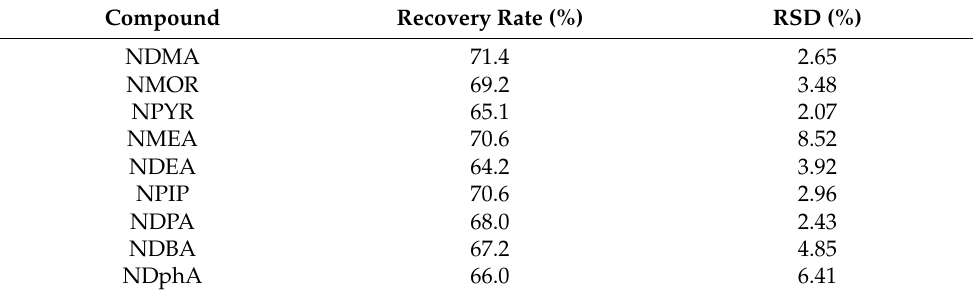
Table 5. Results of recovery rate (n = 6).